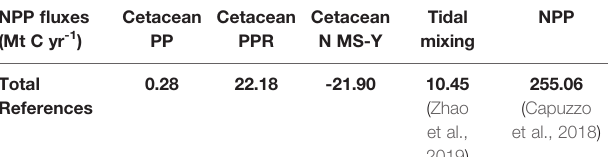
TABLE 10 | Summary of survey area carbon fl